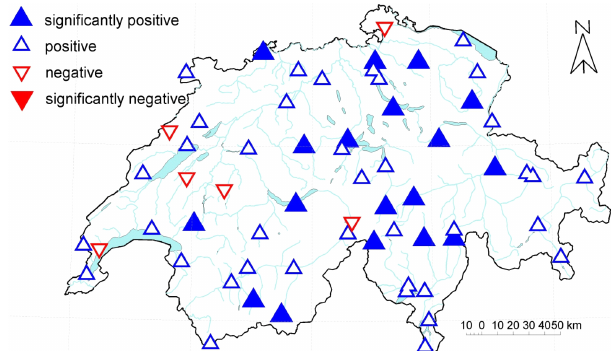
Figure 11. Trends in the number of events per year in which I p > I ∗ over the period 1981–2011 estimated by the non-parametric Mann– Kendall trend test. Upward trends are blue, downward trends are red, and statistically significant trends at the α = 10% significance level have filled